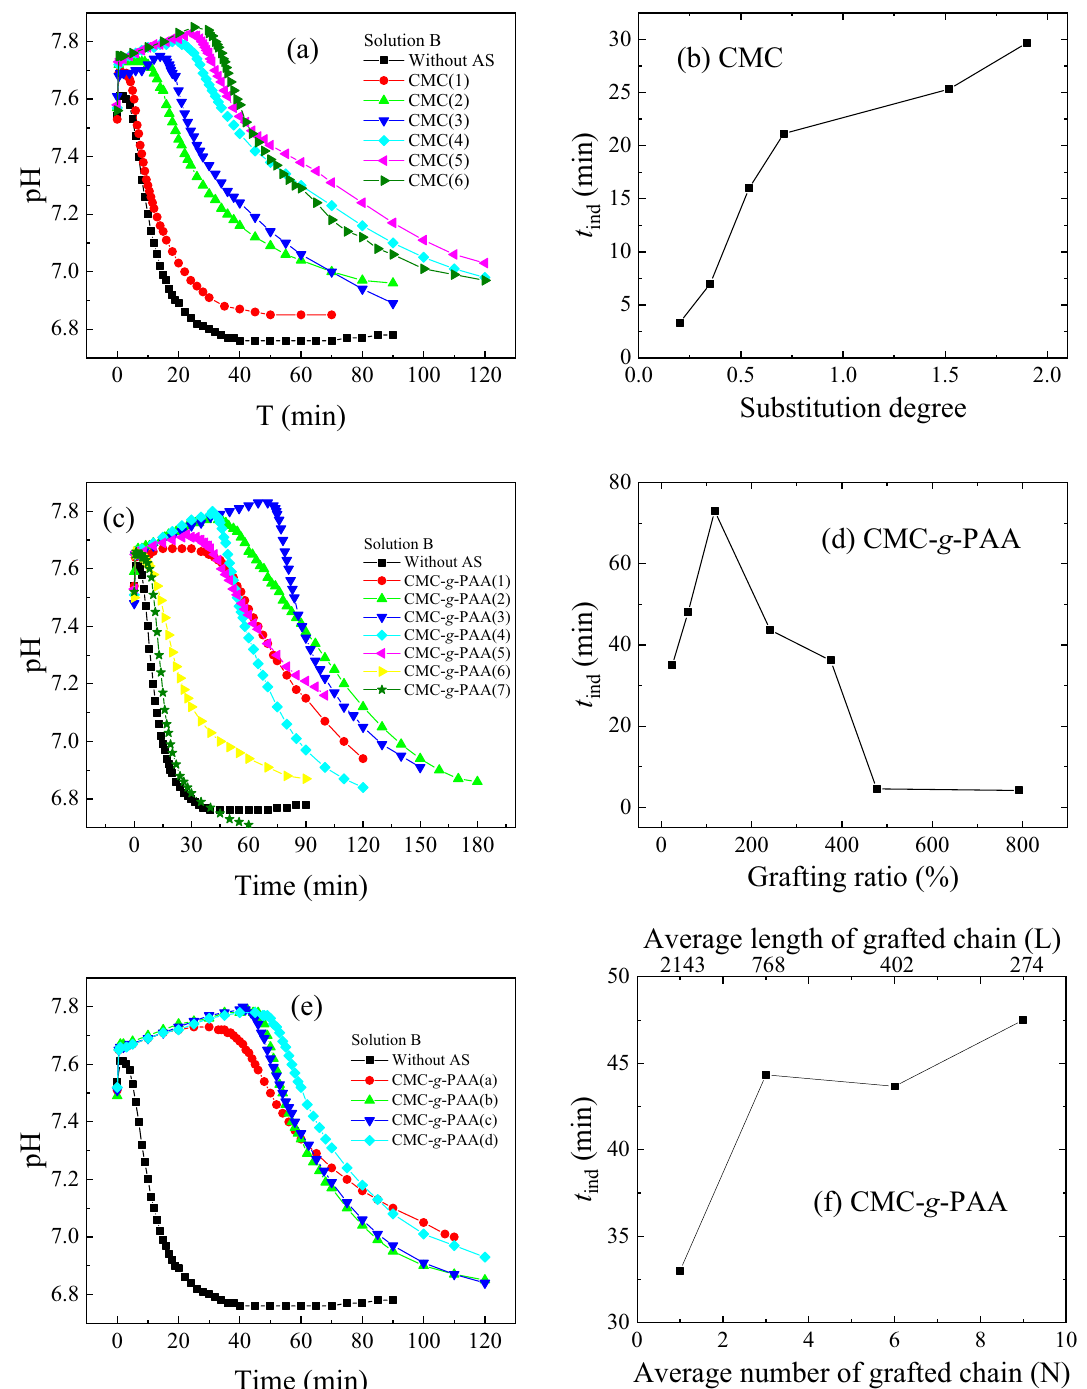
Figure 6. pH changes in the CaCO 3 crystal growth process using Solution B in the absence of antiscalants and ( a ) in the presence of 2.0 mg L −1 CMC(1)–CMC(6), ( c ) in the presence of 1.0 mg L −1 CMC- g -PAA(1)–CMC- g - PAA(7), and ( e ) in the presence of 1.0 mg L −1 CMC- g -PAA(a)–CMC- g -PAA(d). According to ( a ), ( c ) and ( e ), the relations between t ind and different structural factors, i.e., ( b ) degrees of carboxyl substitution, ( d ) grafting ratio, and ( f ) grafted-chain distribution, were summarized. (AS: